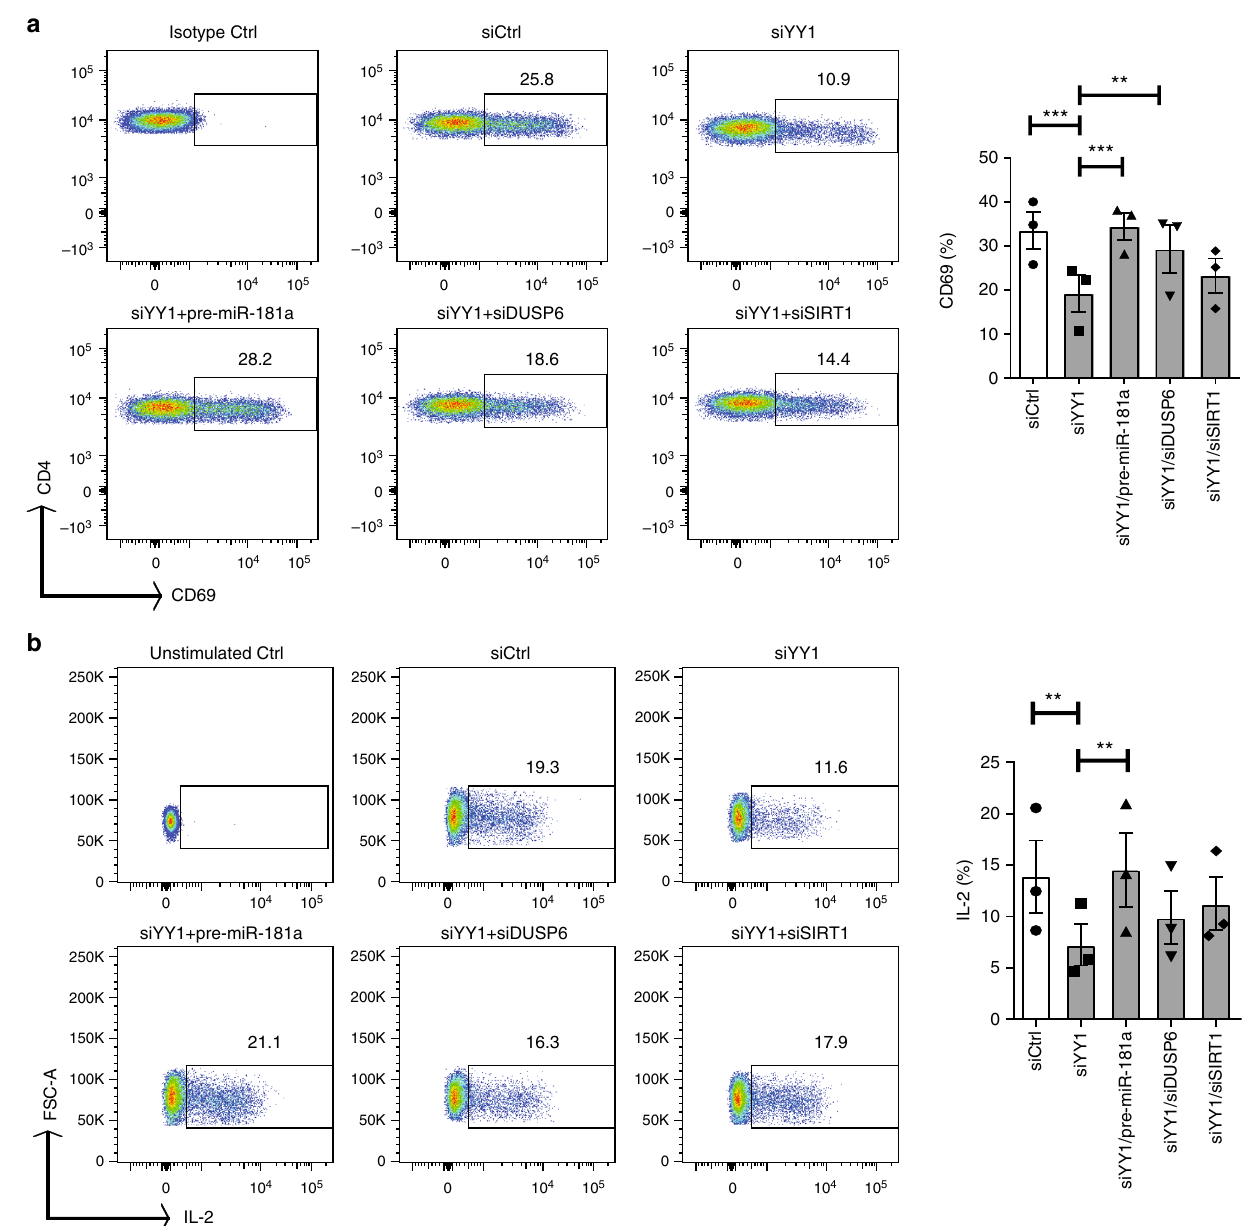
Fig. 6 YY1 regulates T cell activation through controlling miR-181a expression. CD4 naïve T cells were transfected with control siRNA, YY1 siRNA (#1 or #2), a combination of YY1 siRNA and pre-miR-181a, a combination of YY1 siRNA and DUSP6 siRNA or a combination of YY1 siRNA and SIRT1 siRNA. a Cells were cultured in plates coated with 1 µ g CD3/CD28 and analyzed for CD69 expression by fl ow cytometry after 24 h. Results are shown as scatter plots (left) and as mean ± SEM percentages of CD69 + cells from one experiment with YY1 siRNA#1 and two experiments with YY1 siRNA#2 (right). b Transfected CD4 T cells were stimulated with CD3/CD28 Dynabeads (at a cell to beads ratio of 3:1) for 24 h, then restimulated with ionomycin and PMA in the presence of Golgi blocker and assayed for the production of IL-2. Results are shown as representative scatter plots (left) and bar graphs of mean ± SEM from one experiment with YY1 siRNA#1 and two experiments with YY1 siRNA#2. One-way ANOVA and pairwise comparison using the Tukey's method were used in all experiments. ** P < 0.005. *** P < components, thereby slowing proliferation and tumor progres- sion in diffuse large B cell lymphomas 61 . Further studies are needed to understand how these different targets synergize and to develop predictive models of T cell responses in older individuals low in miR-181a expression.